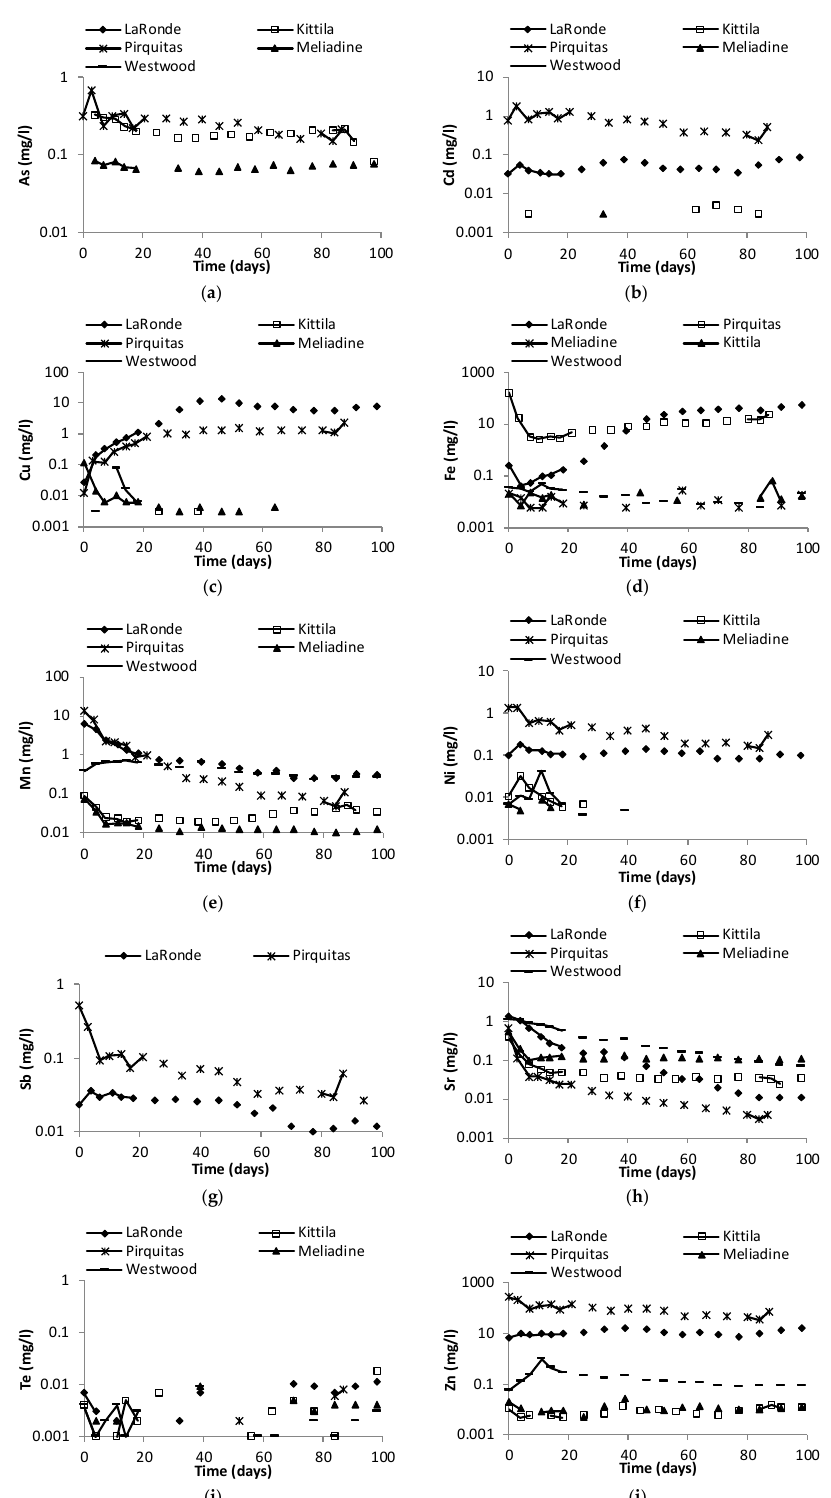
Figure 5. Geochemical results from the weathering cells: concentrations (mg/L) of metals associated with sulfide oxidation in the ore samples; ( a ) As, ( b ) Cd, ( c ) Cu, ( d ) Fe, ( e ) Mn, ( f ) Ni, ( g ) Sb, ( h ) Sr, ( i ) Te, and ( j ) Zn.